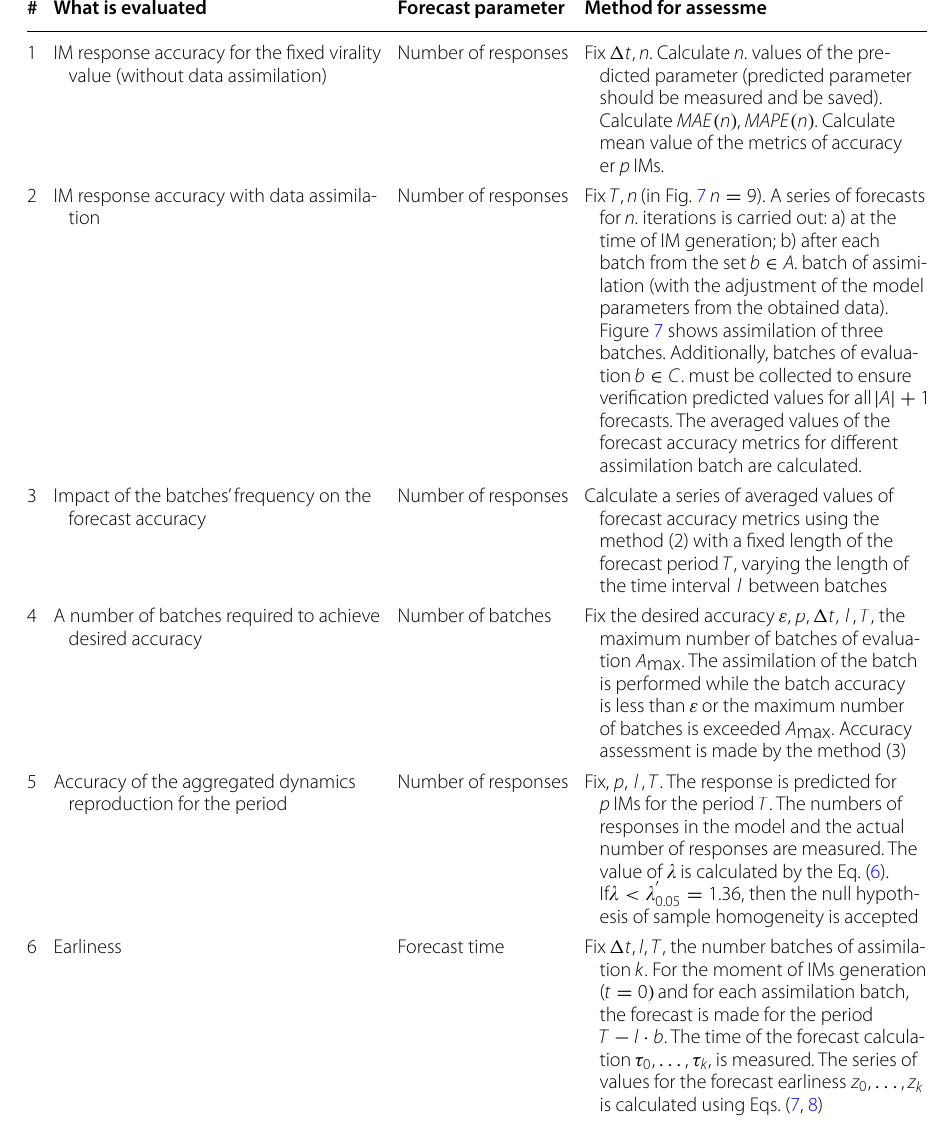
Table 2 Forecast quality assessment’ methods # What is evaluated Forecast parameter Method for